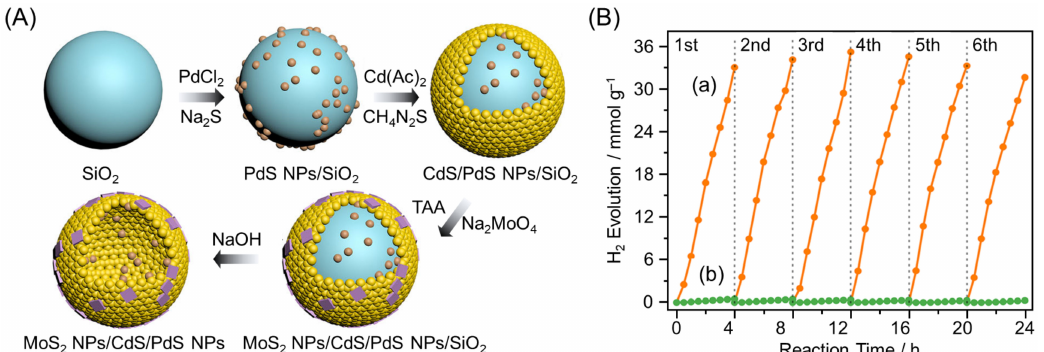
Figure 40. ( A ) Schematic illustration of the synthetic process for MoS 2 NPs/CdS/PdS NPs het- erostructures. ( B ) Cycle stability of H 2 evolution from 0.1 M of Na 2 S–Na 2 SO 3 aqueous solution under Vis-light irradiation (420–780 nm) using (a) MoS 2 (7.5 wt%) NPs/CdS/PdS(1.5 wt%) NPs hollow spheres and (b) CdS hollow spheres (each cycle is 4 h). Reproduced with permission from reference [293]. Copyright 2021 Wiley-VCH.